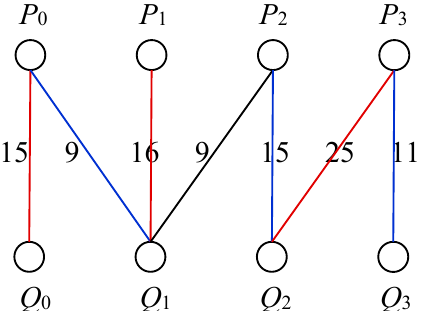
Figure 5. A solution to the maximum edge coloring problem (MECP) (and maximum degree edge coloring problem (MDECP)) when the input is the distribution graph in Figure 4.